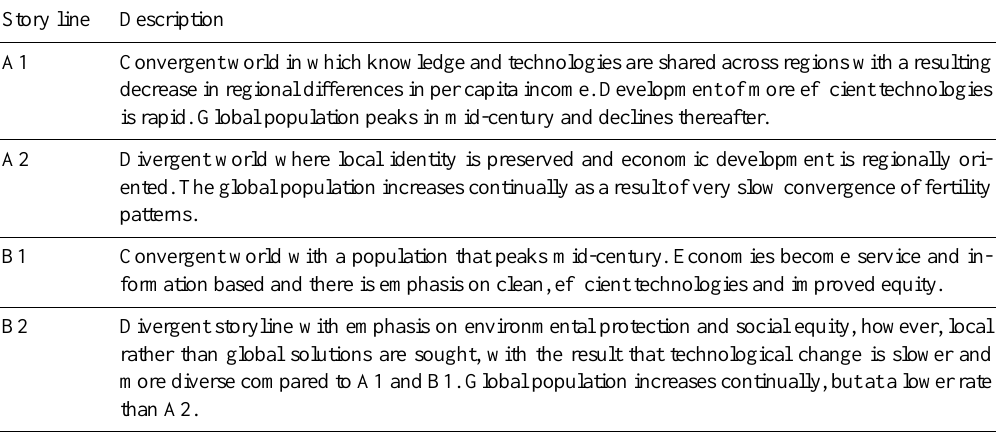
Table 1. Summary of the IPCC AR4/SRES scenario